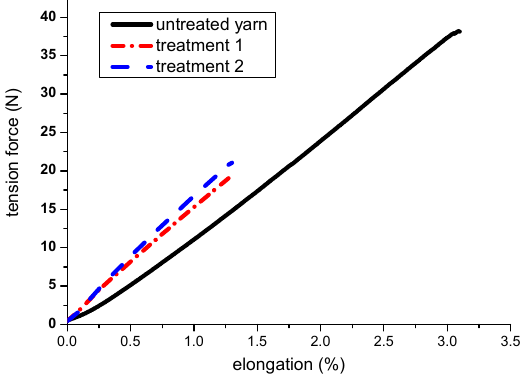
Figure 4. Representative tensile force-elongation curves of treated and untreated yarns. Table 3. Tensile test results of FA treated and untreated yarns (average and standard deviation). Treatments